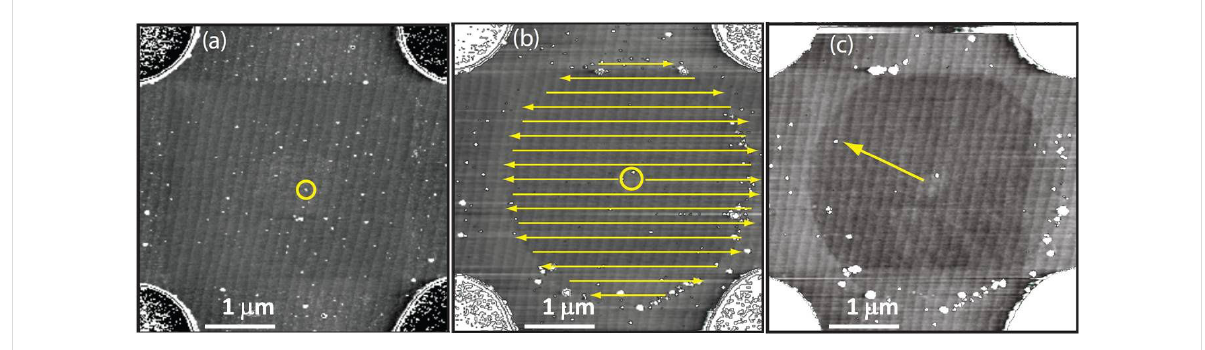
Figure 2: Isolation and manipulation of a single QD. (a) A typical cell after QDs have been spin cast on to the surface. The QD selected for study is highlighted with a yellow circle; (b) The yellow lines show the path that the AFM tip takes in contact mode, clearing a circle around the selected QD. (c) An area around the QD is cleared leaving only two QDs in the centre of the cell. The final QD is removed by nudging the QD with the AFM tip in contact mode with a high tip–sample interaction force. The approximately parallel lines seen in each of the images are atomic step edges on the sapphire substrate.